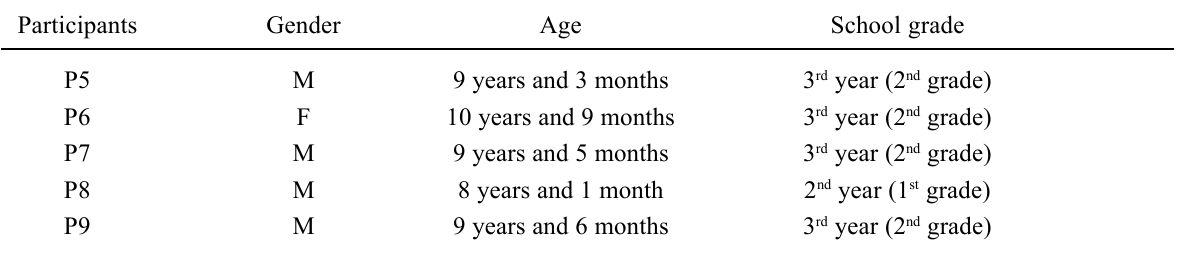
Characterization of the Participants of Study 2 According to Gender, Age (Years and Months at the Beginning of the Study) and School